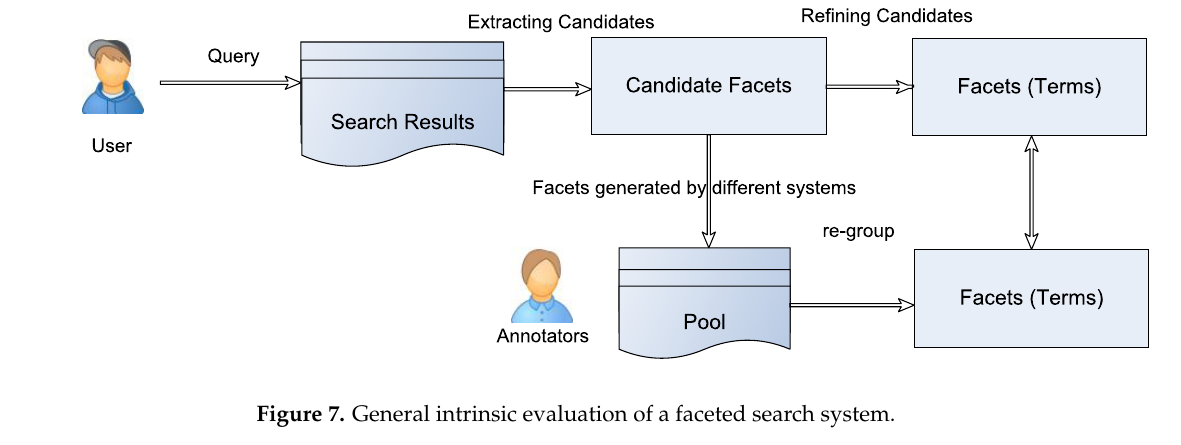
Figure 7. General intrinsic evaluation of a faceted search system.